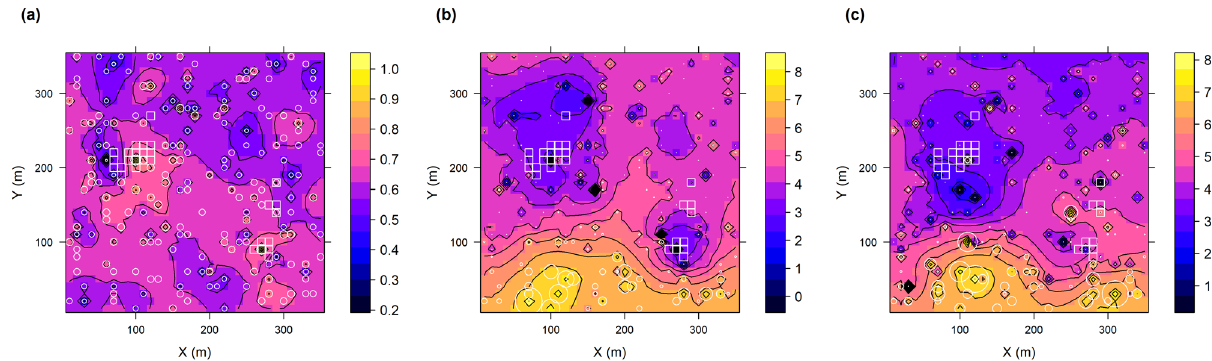
Fig. 4 Kriging heat and contour maps of 2013 pre-treatment macrofaunal diversity and biomass around the oyster reefs. ( a ) Shows diversity (Simpson ’ s D) and ( b ) the summed biomass in AFDW grams per cell of the dominant bivalves M. balthica , and S. plana . For comparison, c shows the summed biomass of M. balthica , and S. plana after the treatment. White 10 * 10 m squares are those >50% occupied by oyster reef. All use simple Kriging prediction, which incorporates a bathymetric trend ( ‘ Y ’ axis) in these data, for interpolation of the sampled points (white circles, radius relative to sample value). Biomass data and scale bars are natural log transformed. See Supplementary Fig. S11 for prediction variance maps and individual species biomass maps. For 2014, M. balthica , and S. plana biomass samples were complete but sampling issues for other species precluded a comparable diversity